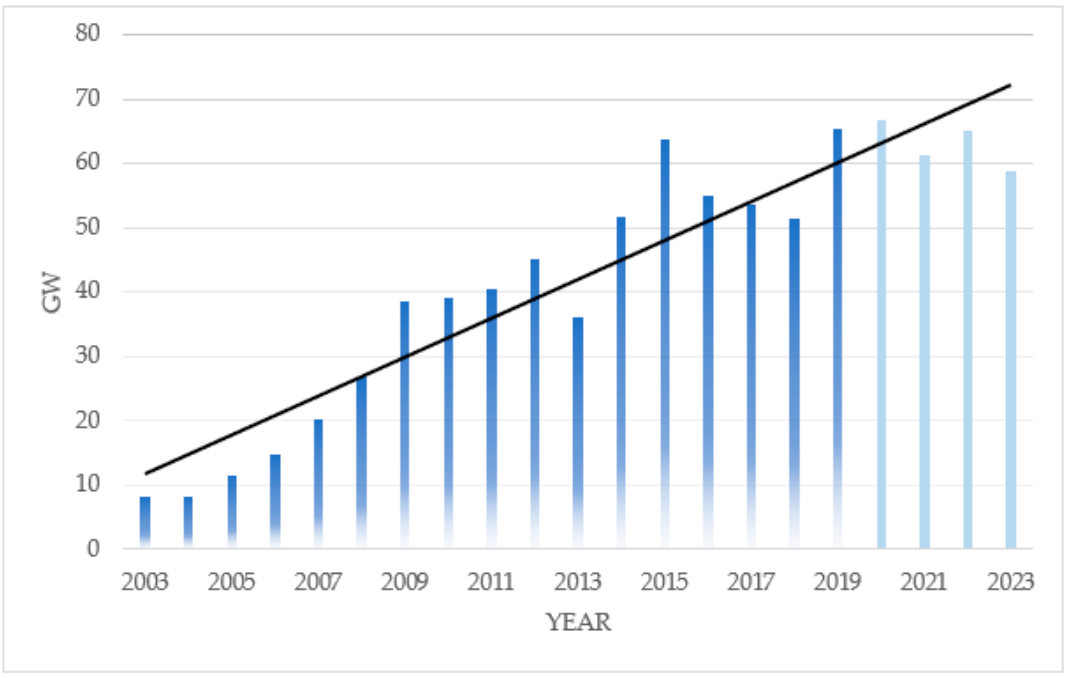
Figure 1. Wind energy capacity and forecast [2].